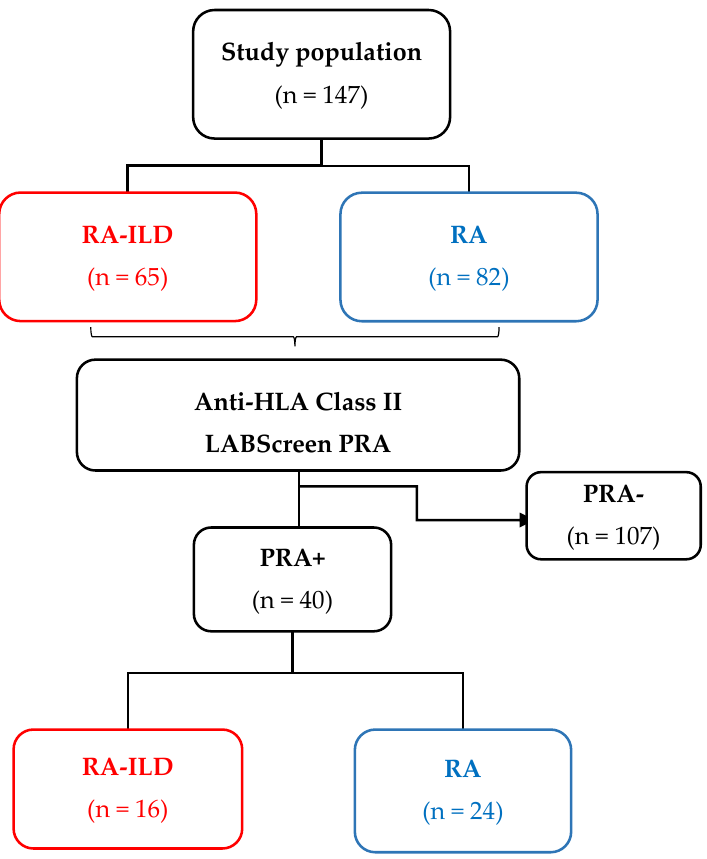
Figure 1. Sera panel-reactive antibodies (PRA) analysis included samples from the 147 Rheumatoid Arthritis (RA) patients (with or without Interstitial Lung Disease (ILD)) for the LABScreen system. The percentage of women in the study groups exceeded 50.0%, being the RA-ILD group, where the lowest percentage (53.0%) was found compared to the RA group with 81.0 % ( p = 0.002). In the